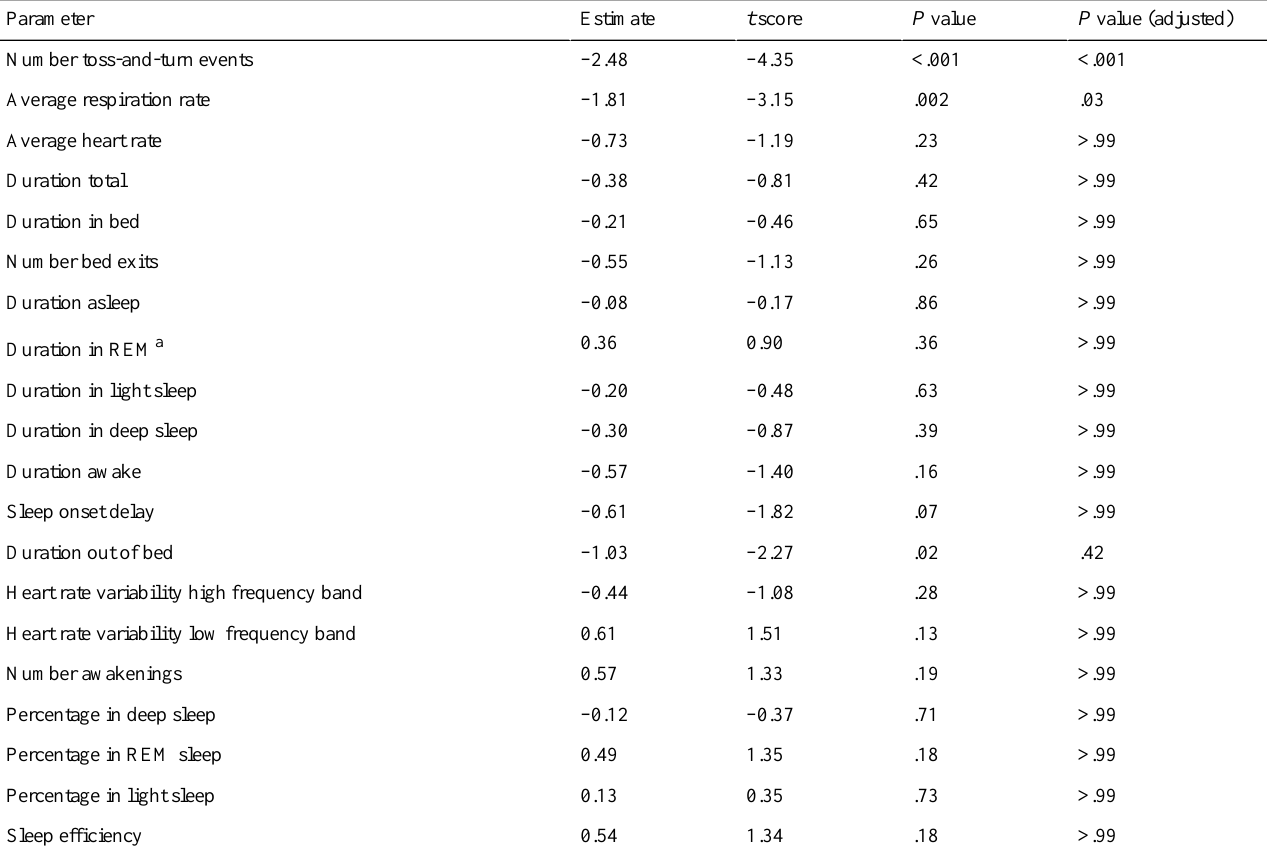
P value (adjusted) P value t scoreEstimateParameter